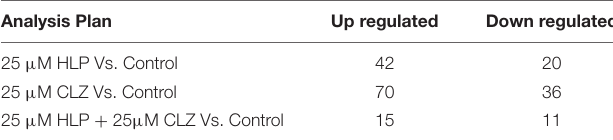
TABLE 1 | Number of microRNAs (miRNAs) upregulated and downregulated in each antipsychotic drug treatment group. Analysis